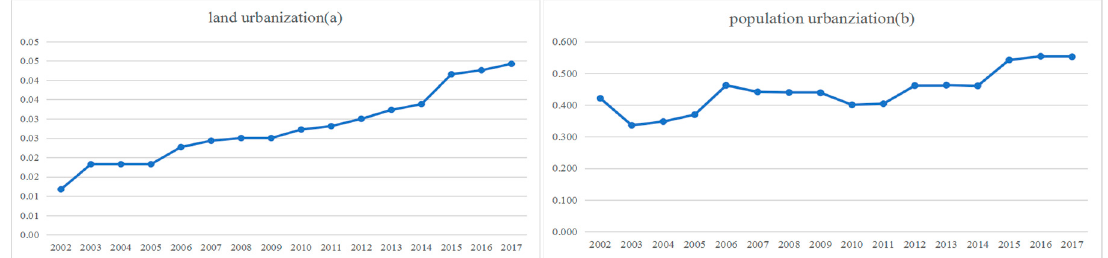
Figure 3. Temporal trend of land urbanization ( a ) and population urbanization ( b ) in Nanchang from 2002 to 2017.